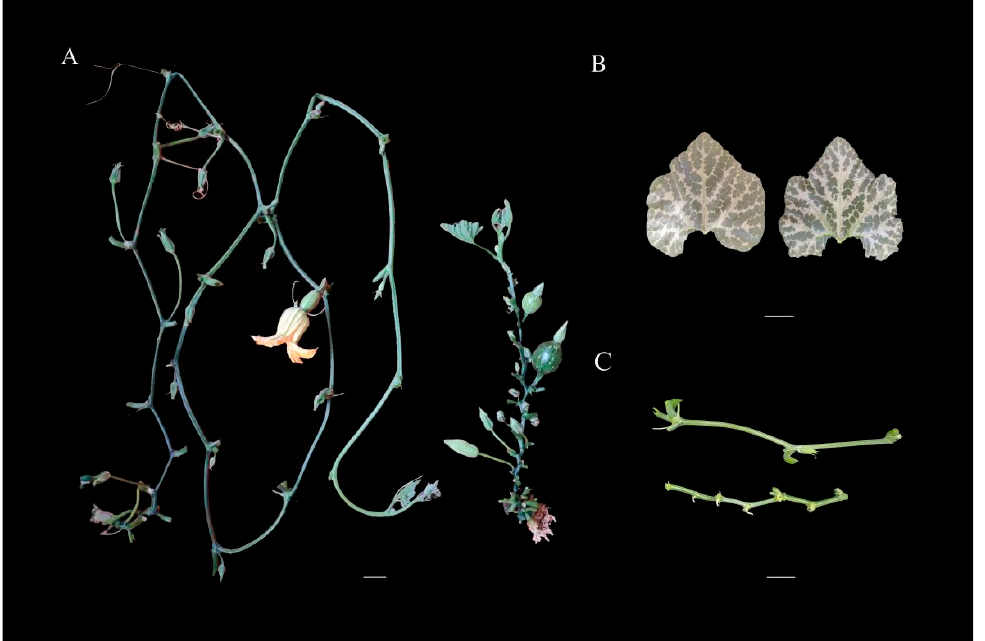
Figure 1. Morphological characterization of the two parental lines, Si1 and WT N87. ( A ), The whole- plant phenotypes of Si1 and WT N87. Bar, 5 cm. ( B ), Phenotype of a leaf of Si1 and WT N87. Bar, 2 cm. ( C ), Phenotype of the internodes of Si1 and WT N87. Bar, 2 cm.